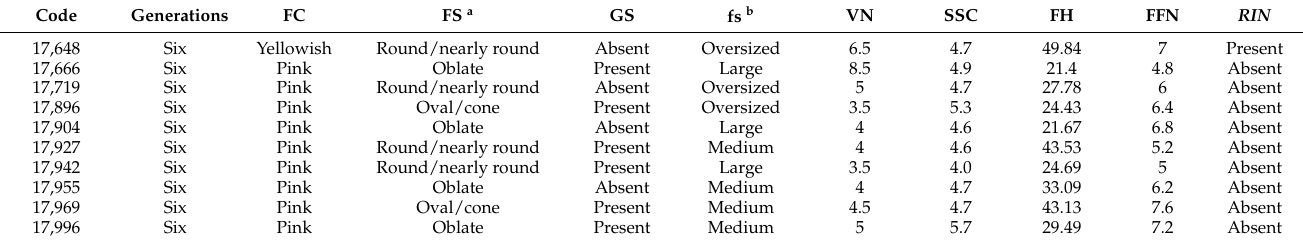
FC—Fruit color, FS—Fruit shape, GS—Green shoulder, fs—Fruit size, VN—Ventricular number, SSC—Soluble solid content, FH—Fruit hardness, FFN—First flower node. a Oblate: The fruit shape index is between 0.6 and 0.8. Round/nearly round: The fruit shape index is between 0.8 and 0.9. Oval/cone: The fruit shape index is between 0.9 and 1. Obround: The fruit shape index is greater than 1. b Medium fruit: The fruit weight is less than 180 g. Large fruit: The fruit weight is less than 220 g and greater than 180 g. Oversized fruit: The fruit weight is greater than 220